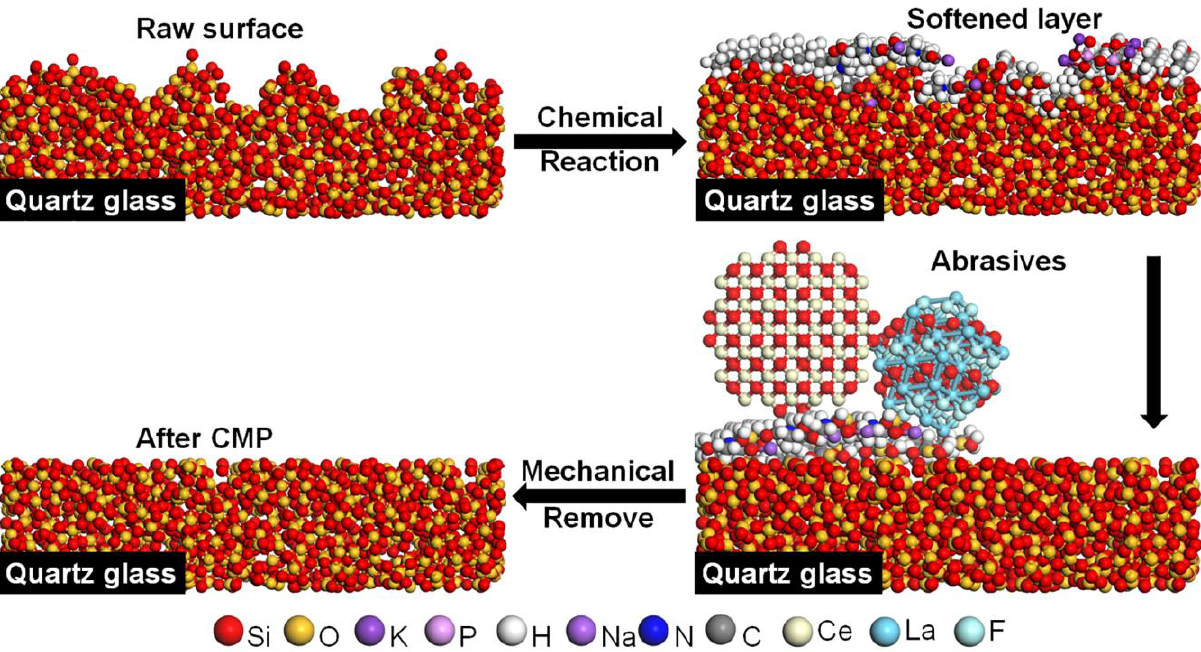
Figure 11. Chemical mechanical polishing mechanism of the slurry in this work.